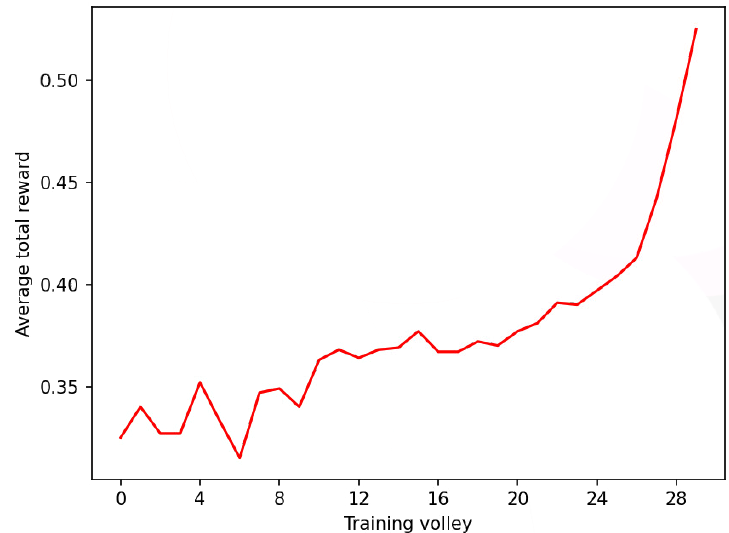
Figure 6. Average total rewards during training of π RF with N = 5 and T = 100 steps. Volleys are composed of 2000 episodes each.